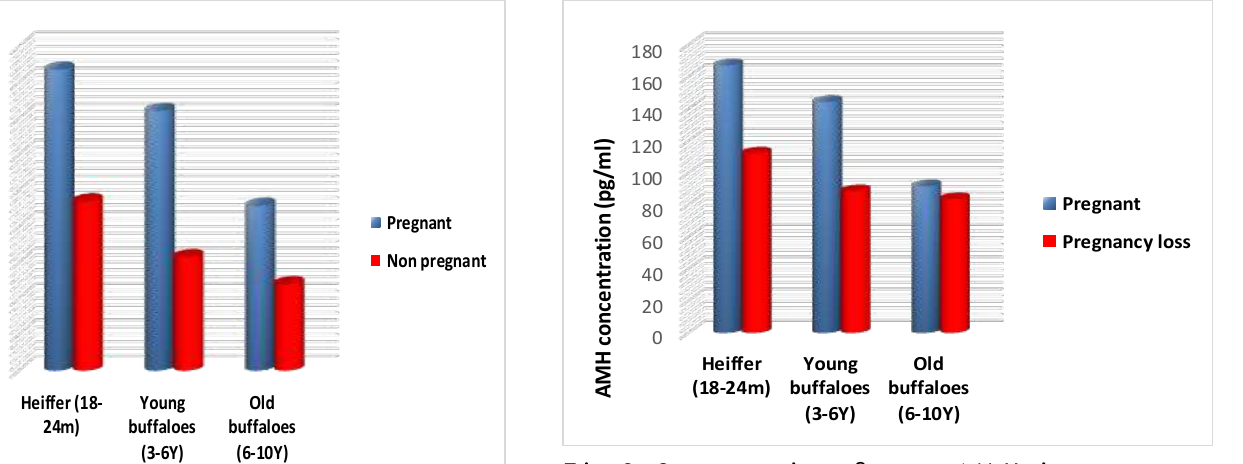
Fig. 3: Concentration of serum AMH in pregnant and buffaloes with pregnancy loss (loss between day 30- day 60) on 60 th day after insemination DISCUSSION Results revealed that under